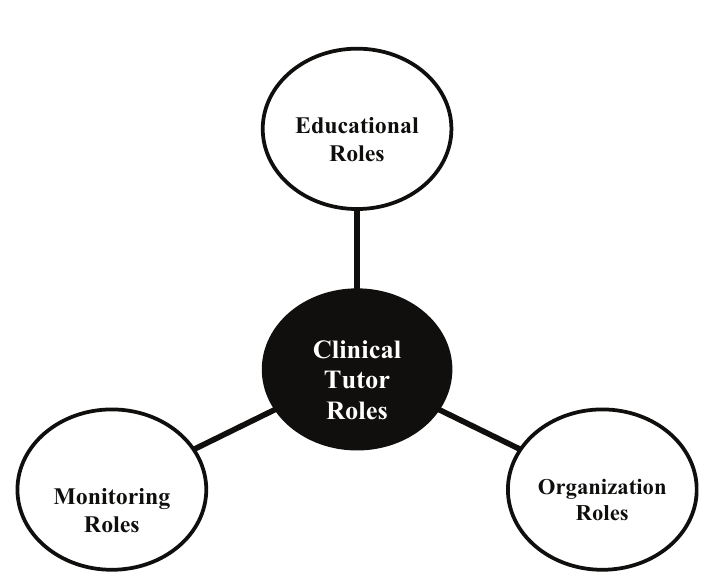
Figure 2: The triangular roles of the clinical